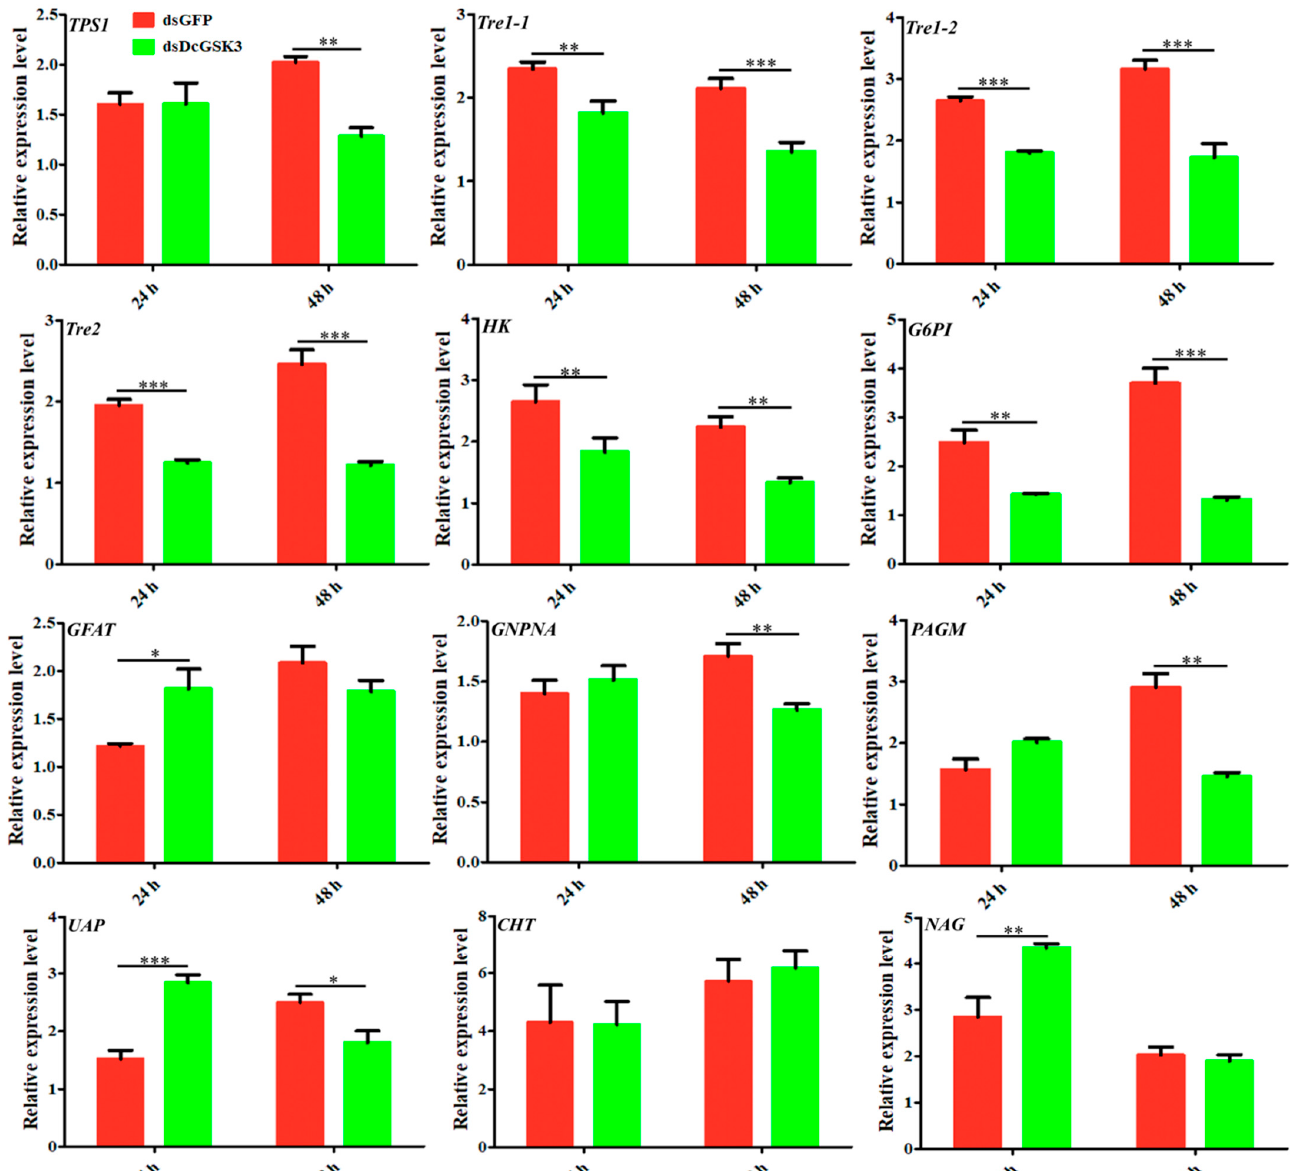
Figure 7. Effects of silencing DcGSK3 on expression levels of twelve genes involved in chitin metabolism in D. citri . The ds GFP treatment group was used as a control. The mean expression level represents three biological replicates. The asterisks indicate significant differences by * ( p < 0.05), ** ( p < 0.01) and *** ( p < 0.001).